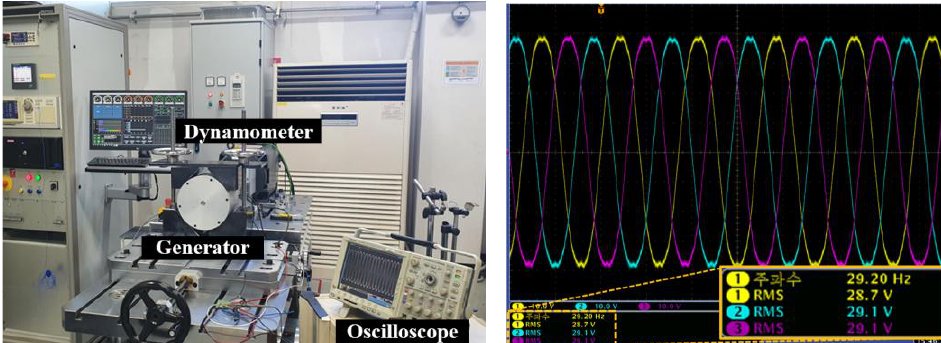
Figure 19. Test and no-load BEMF measurement. Table 5. Comparison of FEA and test